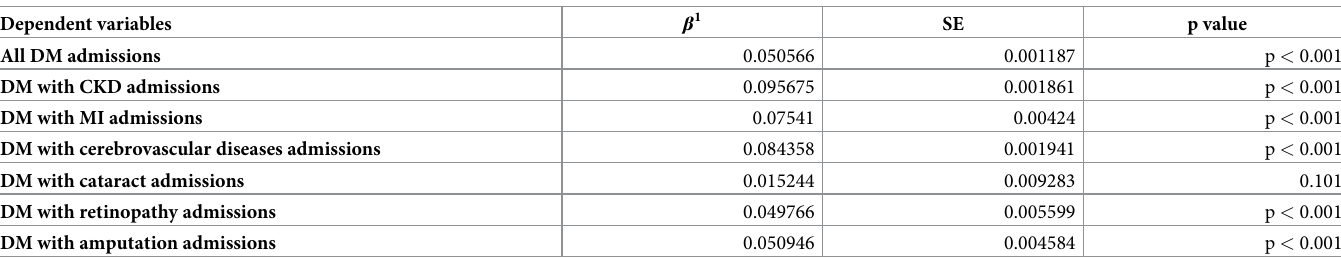
Table 2. Temporal trend analysis for the number of each admission by